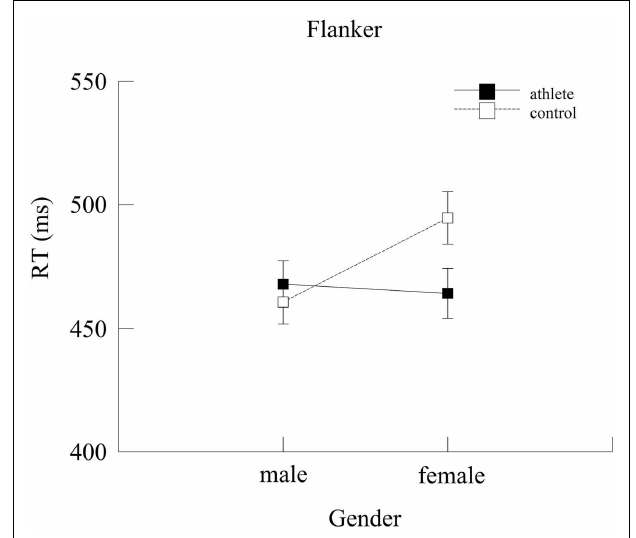
FIGURE 4 | Stop probability for the two groups as a function of age. Error bars represent ± 1 standard error. adultathleteshadahigherprobabilityof stopping( p < 0.001)than adult controls (0.57 ± 0.007 and 0.53 ± 0.01 ms, respectively).